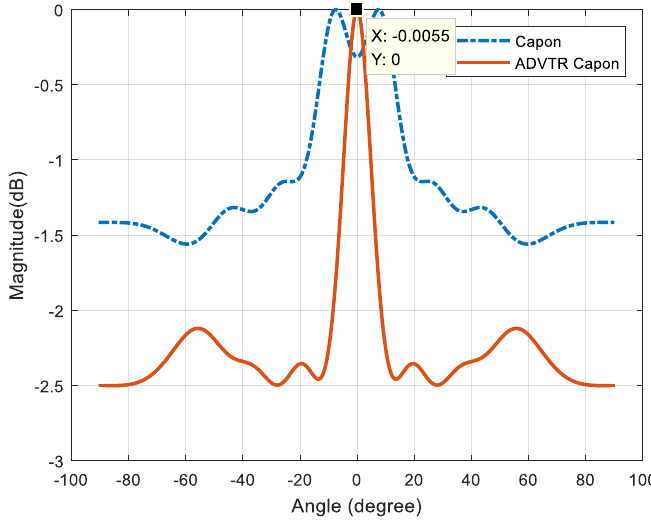
Figure 15. Capon estimator and ADVTR Capon estimator in the tank when SNR is − 8 dB.